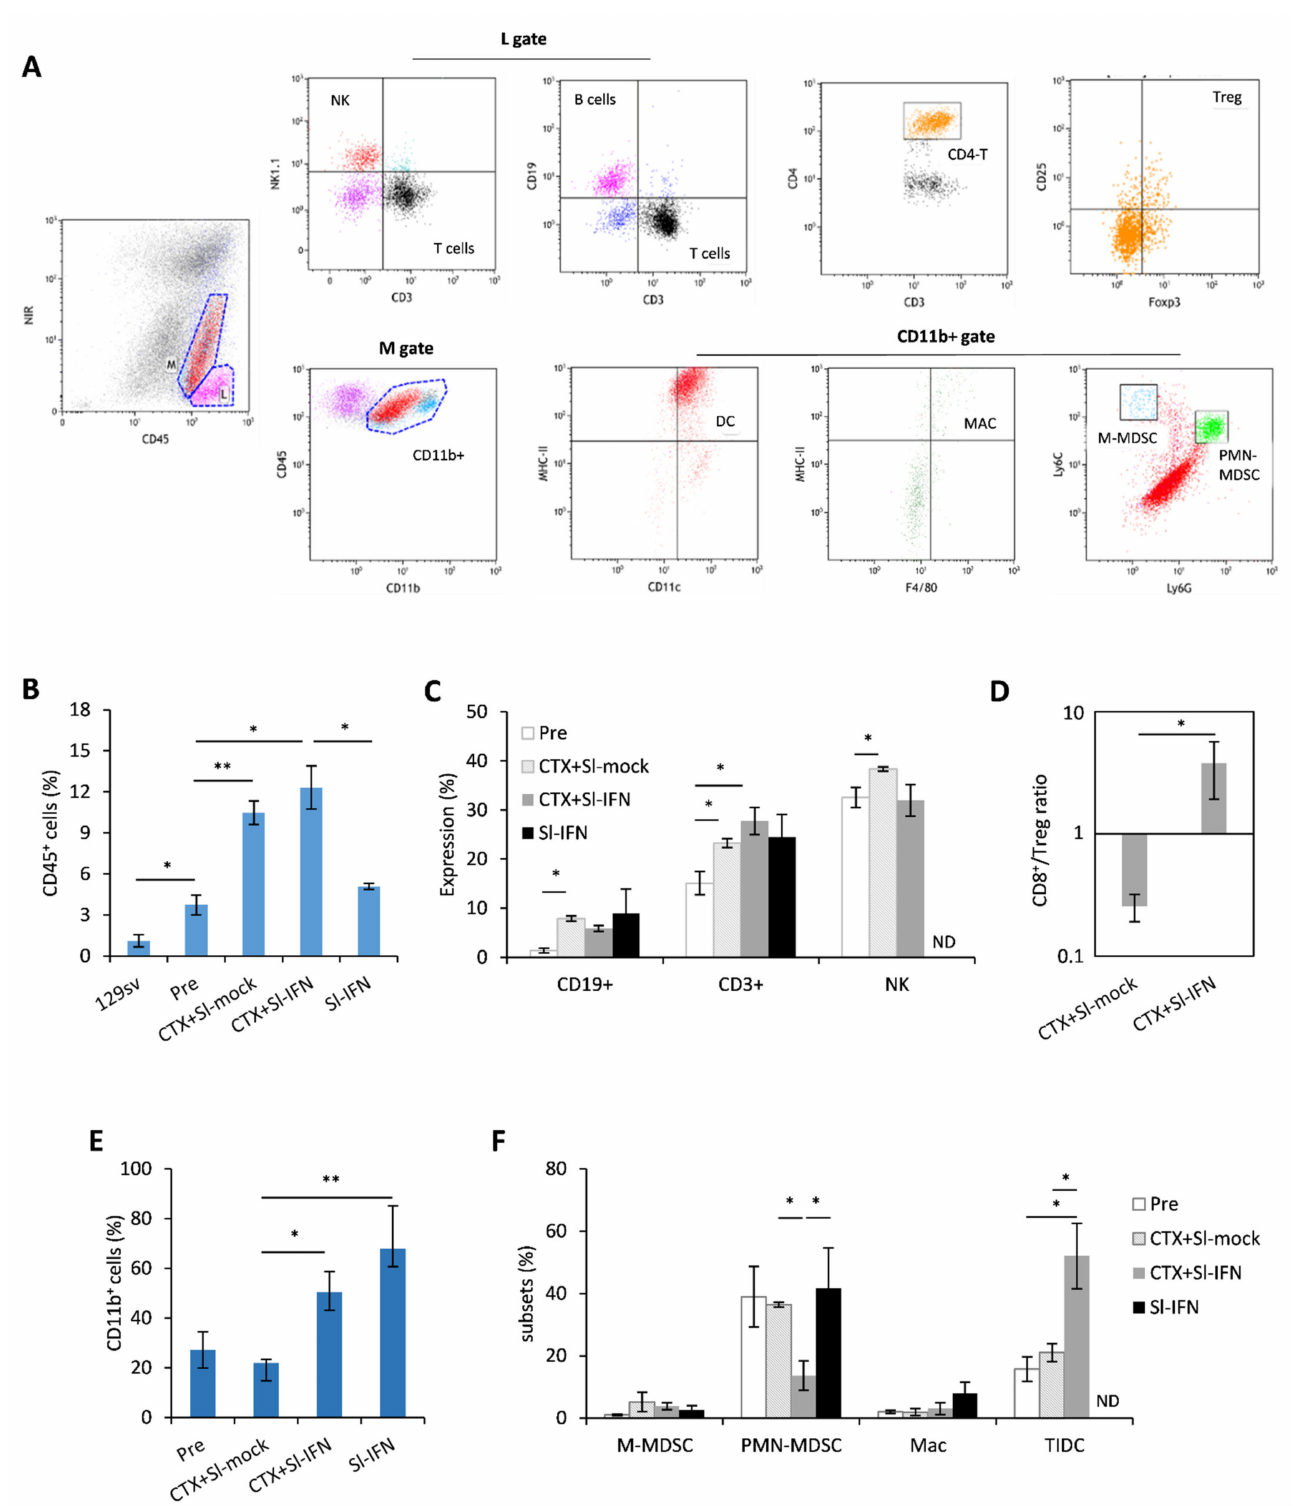
Figure 6. Analysis of leucocyte subsets in the tumor mass 22 days after treatment. ( A ) Representative dot plots of the gating strategy for lymphoid and myeloid subsets in tumor cell suspensions. ( B ) Percentage of CD45 + tumor-infiltrating cells in the tumor mass of NeuT 129sv mice treated with CTX and Sl-mock or Sl-IFN or with Sl-IFN alone as detailed in Section 2 ( n = 4). ( C ) Percentage of the indicated lymphoid subsets in the tumor mass after gating on CD45 + SSC lo cells. ( D ) CD8 + T/Treg ratio in the tumor. ( E ) Percentage of CD11b + after gating on viable CD45 + cells, and of ( F ) tumor-infiltrating myeloid cell subsets. Myeloid subsets percentage is calculated after gating on CD11b + cells. * p < 0.05; ** p < 0.01. ND, Not